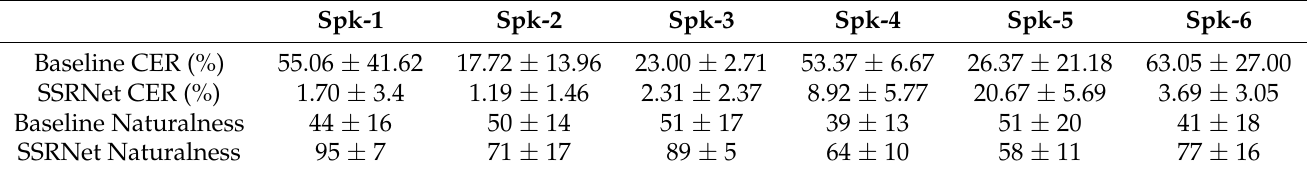
Table 5. Subjective Comparison between Reconstructed Voices from the Baseline and